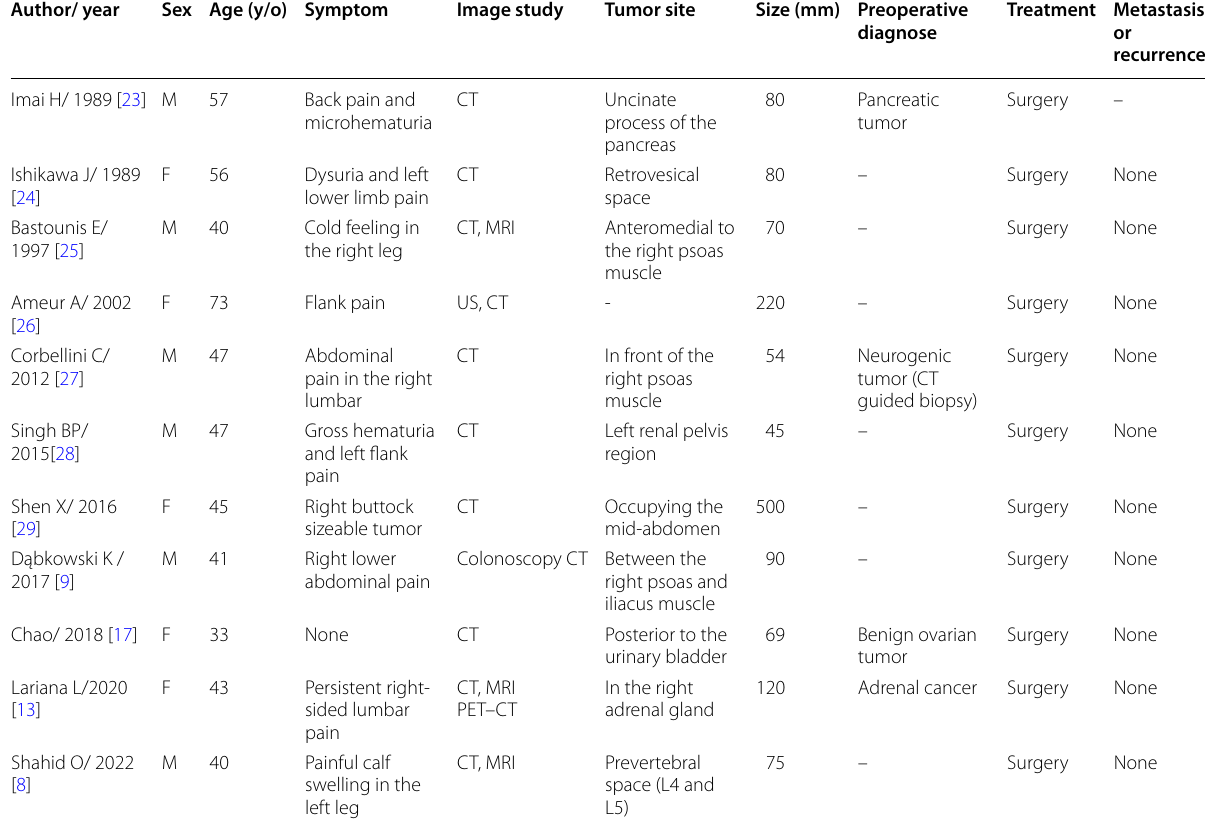
Table 2 The reported 11 cases of the retroperitoneal solitary